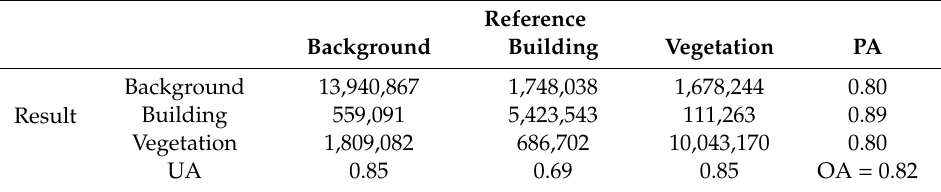
Table 8. Confusion matrix of VBSPM result for Potsdam dataset.